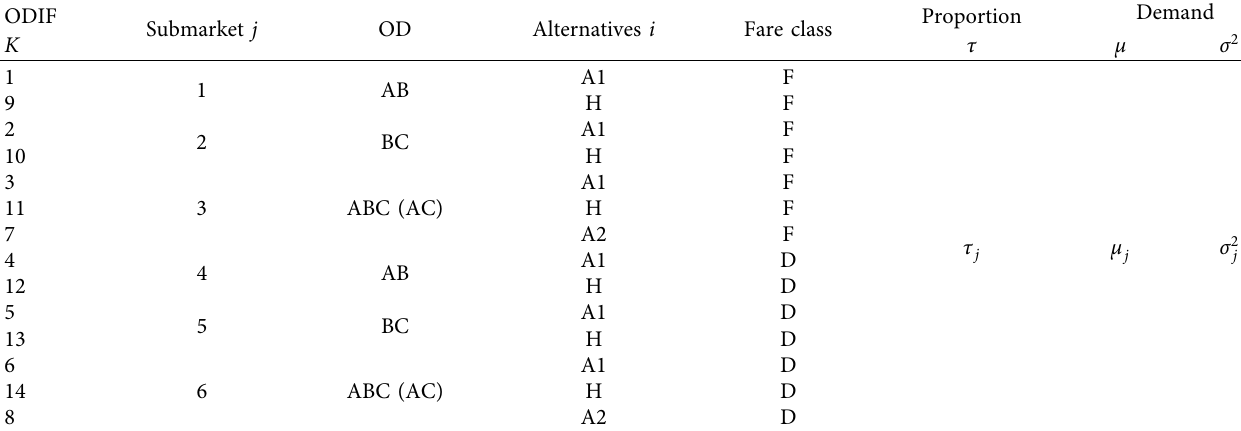
Table 3: Customer arrival of different submarkets and